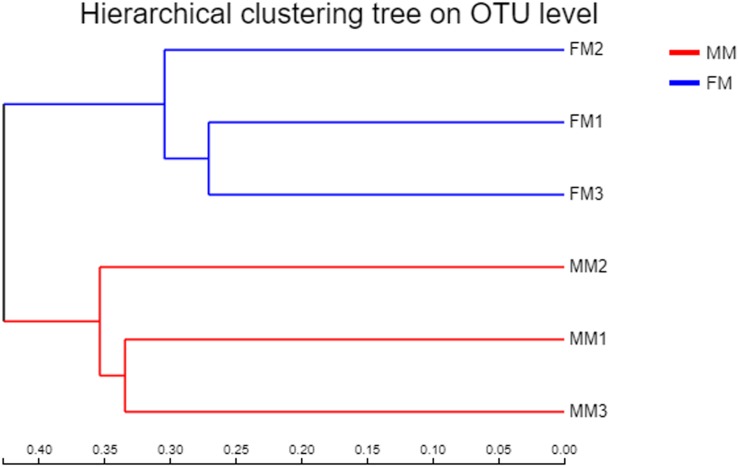
Clustering tree constructed by UPGMA (FM, female swamp eel; MM, male swamp eel).